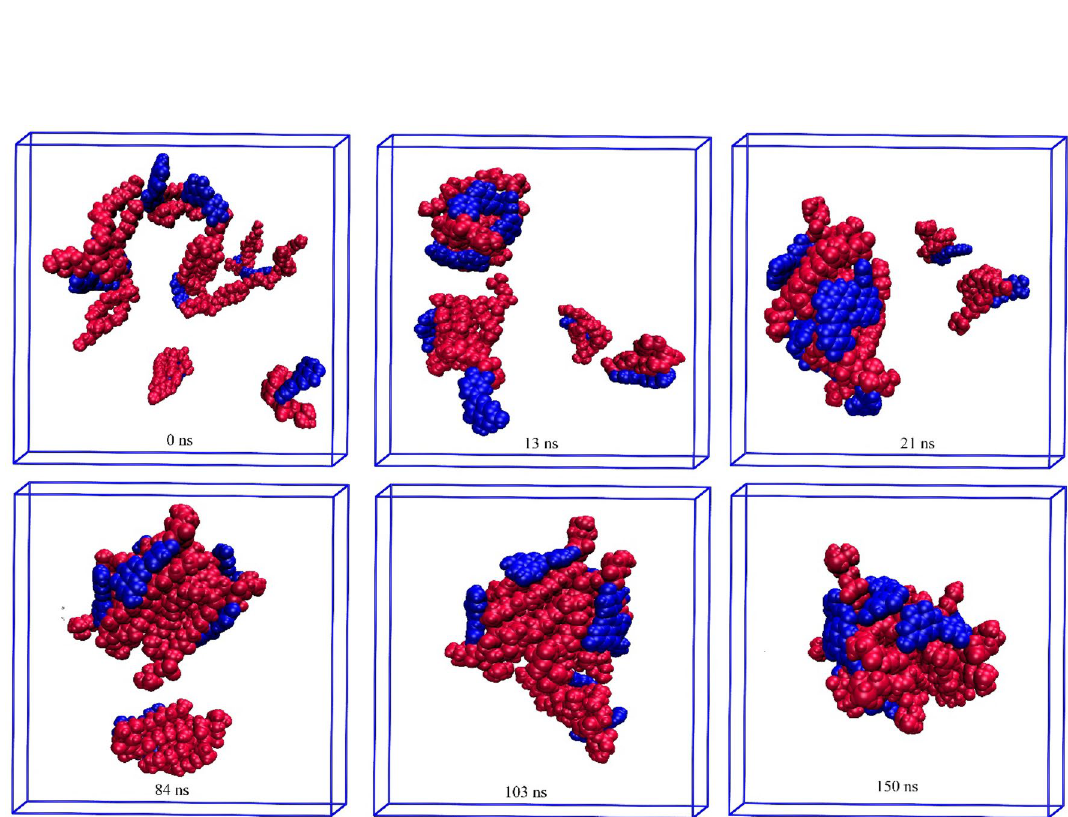
Figure 11. Self-aggregation process of Lu-PC monomers into a phytosome as a function of MD simulation time. Color code; Lu: blue and PC: